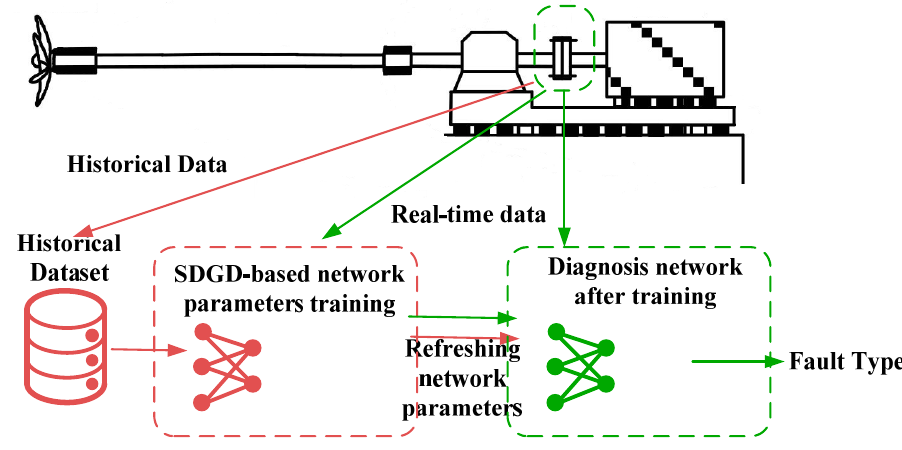
Figure 14. Model figure of sparse gradient denoising optimized diagnosis network. The SDGD optimized neural network model consists of three main components: the